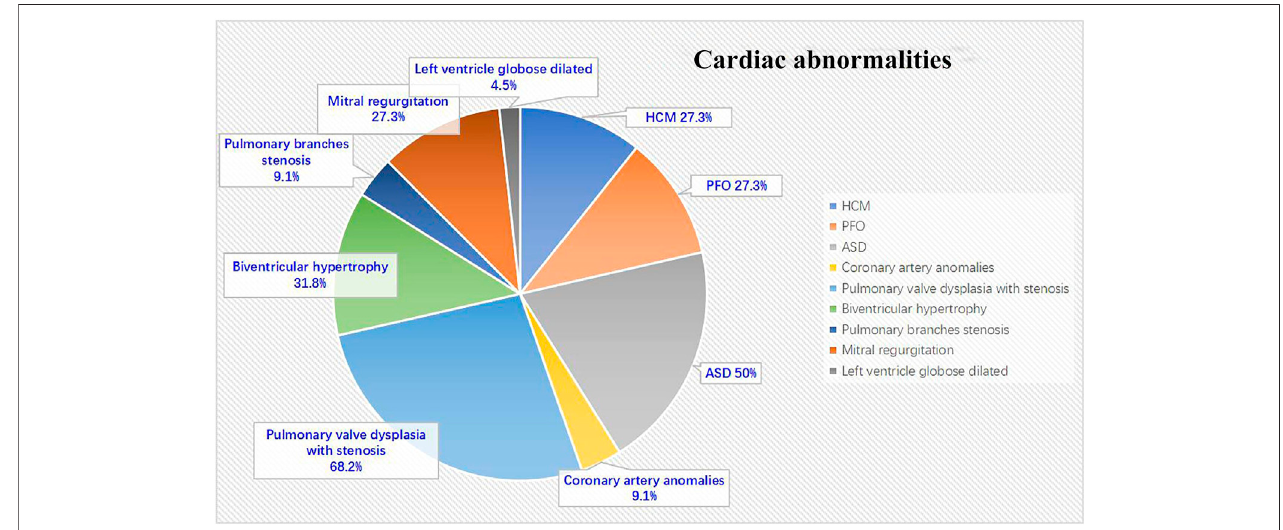
FIGURE 1 | Cardiac abnormalities in NS patients (N = 22).